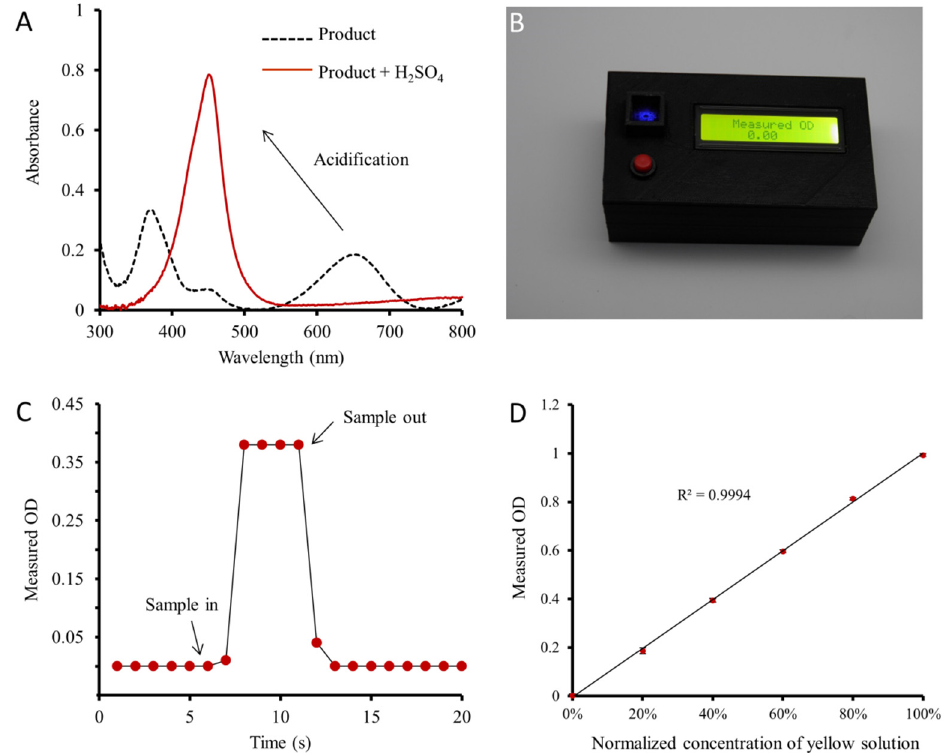
Figure 3. Evaluation of the portable instrument. ( A ) Absorption spectra of the colored compound before (dash line) and after (solid line) acidification. ( B ) A photo that a portable instrument using blue LED was measuring OD. ( C ) Response of the instrument during sample in/out. The sampling interval of the instrument was 1 s. ( D ) Measurement of a series of diluted sample solutions by the portable instrument ( n = 3).